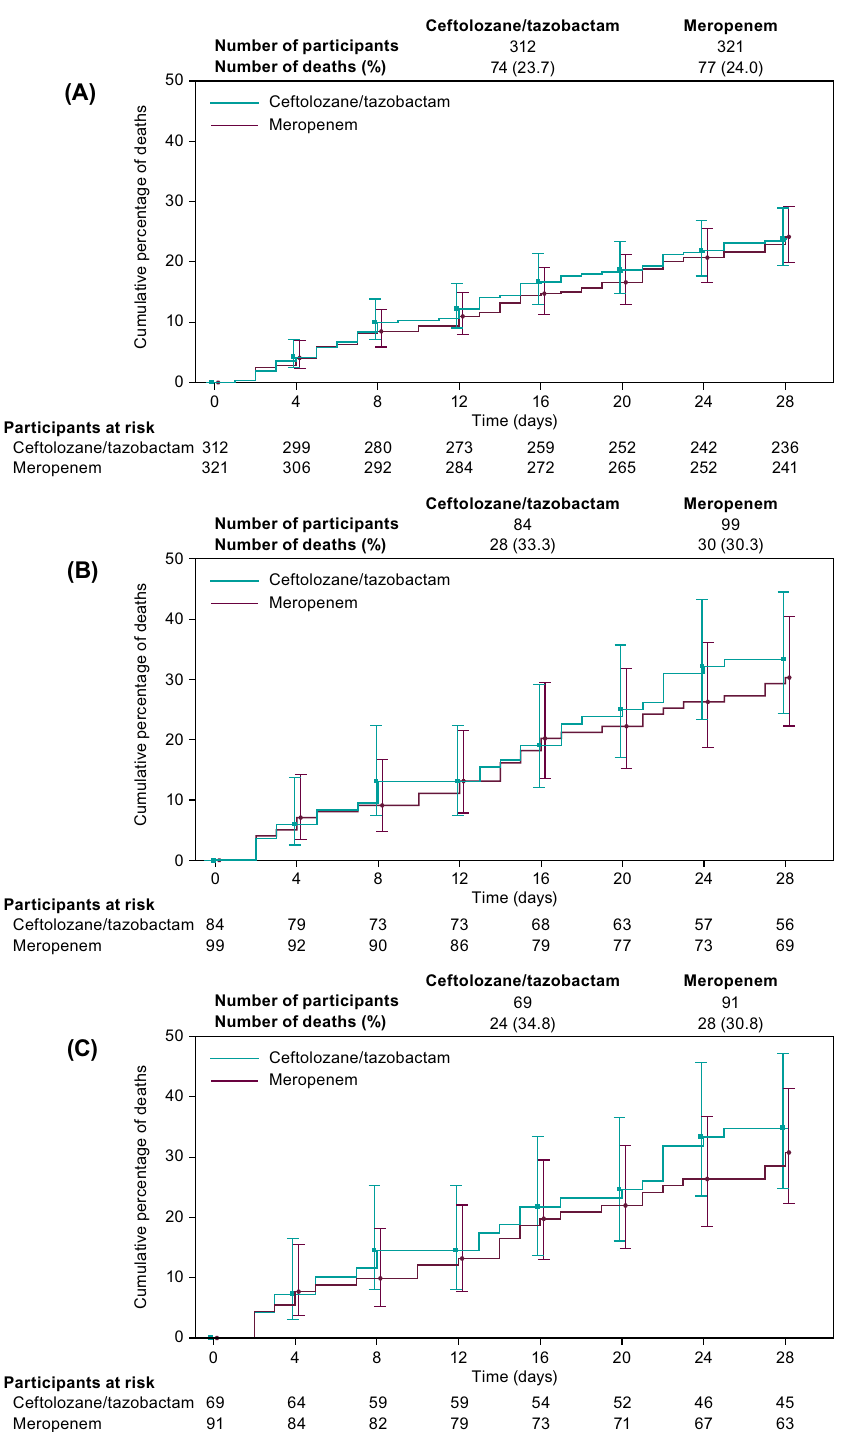
Fig. 4 Time to death by SOFA component score (ITT population). R‑SOFA CV‑SOFA 2 (bottom panel C ). CV-SOFA cardiovascular SOFA component score, R-SOFA respiratory SOFA component score, SOFA Sequential Organ ≥ Failure